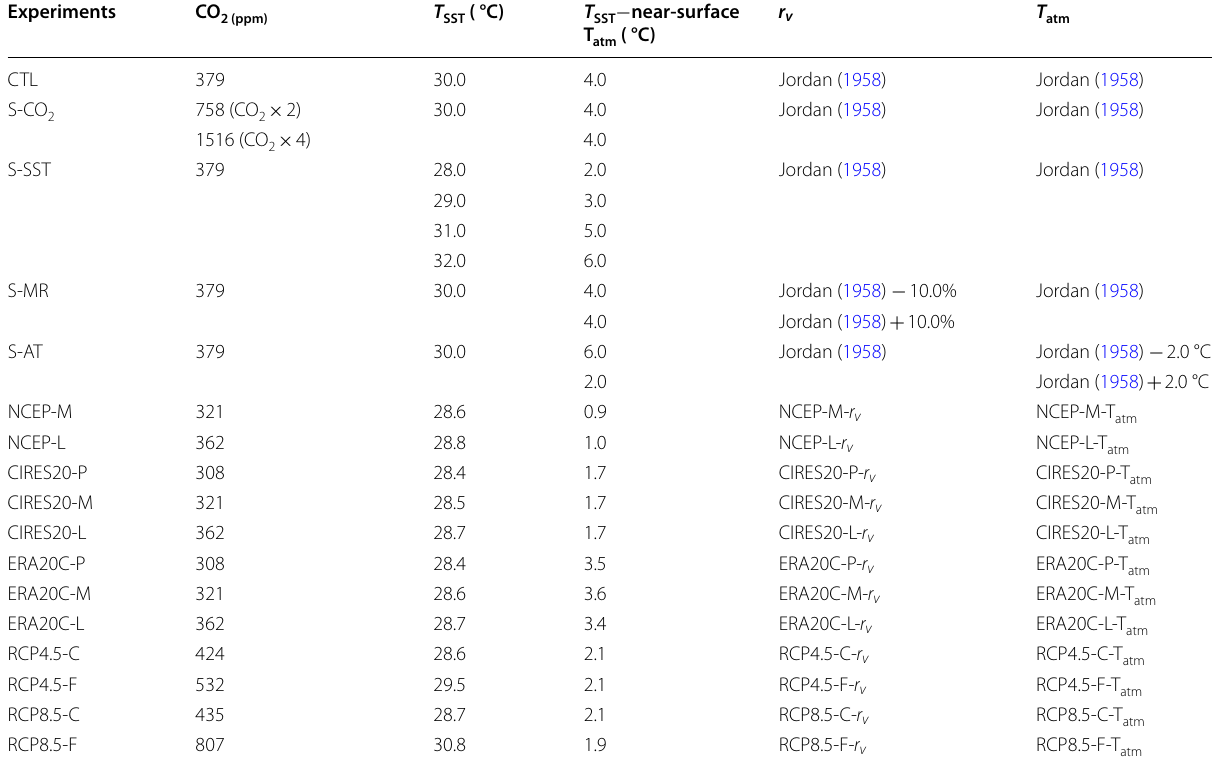
The profiles of T atm and r v are shown in Fig. 2